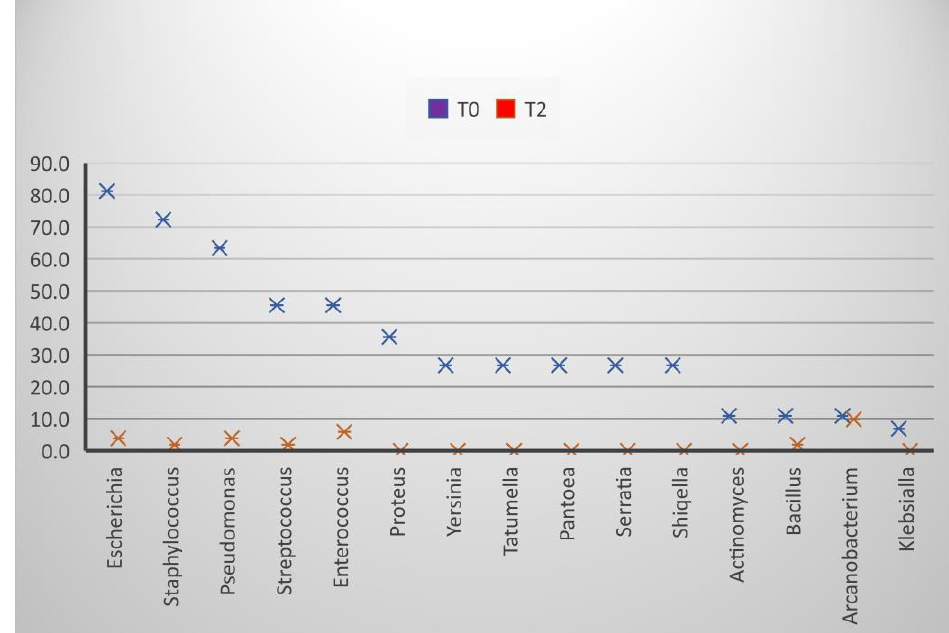
Figure 2. Graphic representation of the percentage of microbiological load in boar semen 24 h after dilution and storage at 17 °C . The minimum level of bacterial load is observed, but the fungal load remains constant, especially the genus Candida .